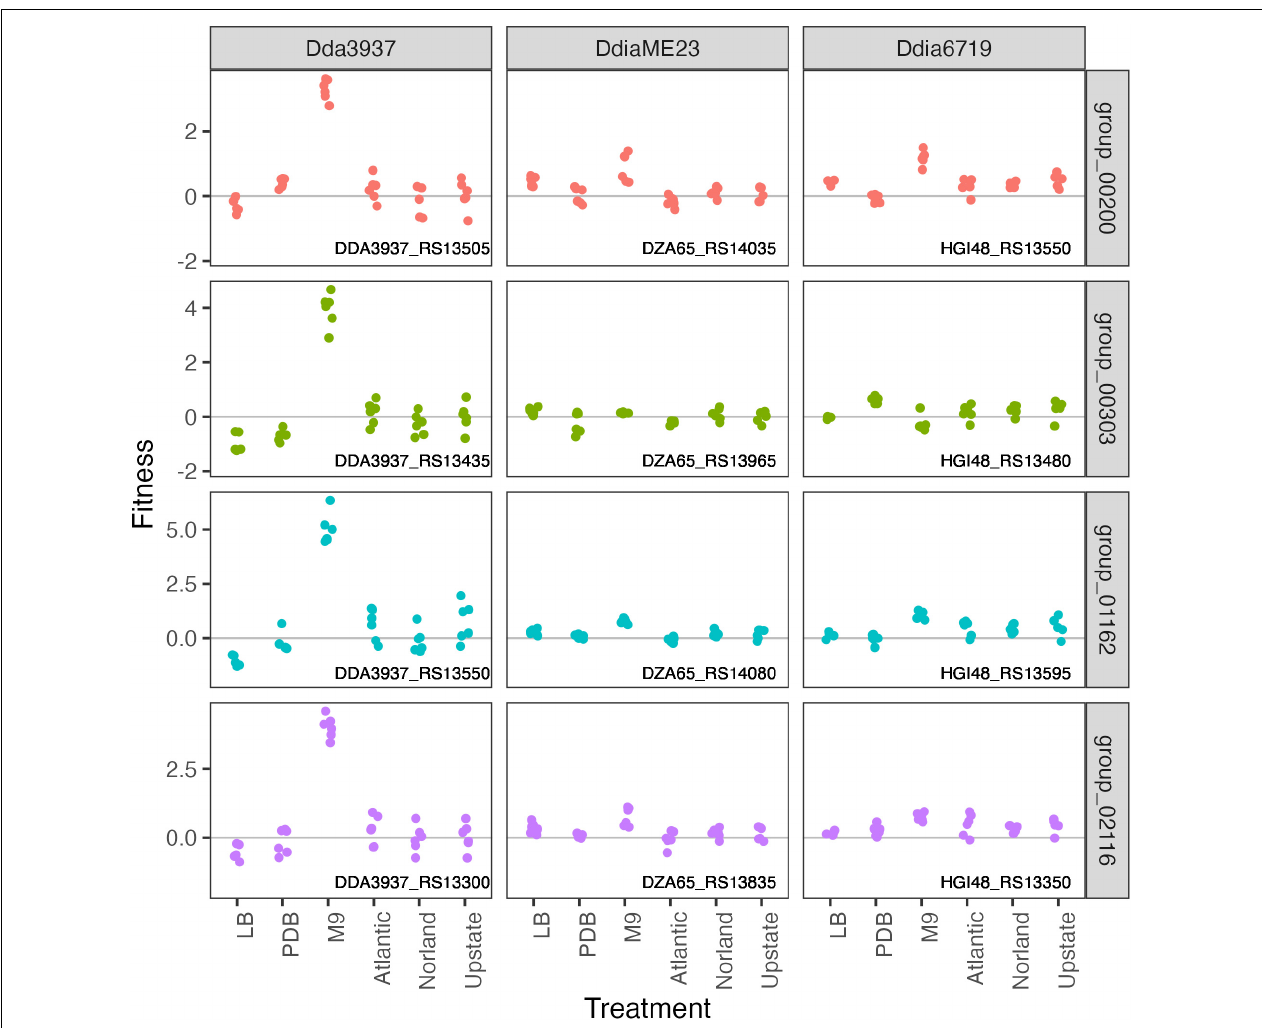
FIGURE 5 | Mutations in flagellar-associated genes increase competitive fitness of D. dadantii 3937 in M9 minimal medium. Gene fitness values for flagellar biosynthesis protein FlhA (group 00200), flagellar hook-associated protein FlgK (group 00303), flagellar motor protein MotB (group 001162), and RNA polymerase sigma factor FliA (group